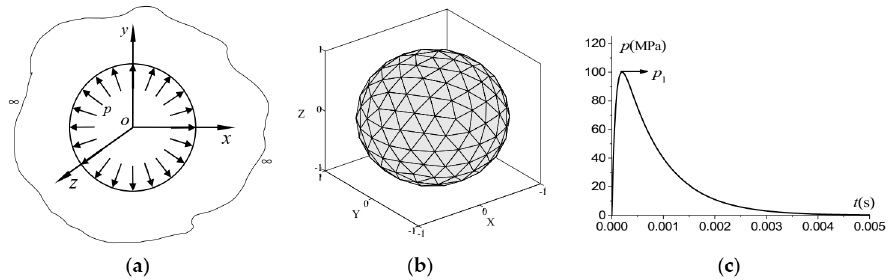
Figure 12. Sketch of the example of spherical cavity: ( a ) geometry; ( b ) boundary discretization; ( c ) explosive